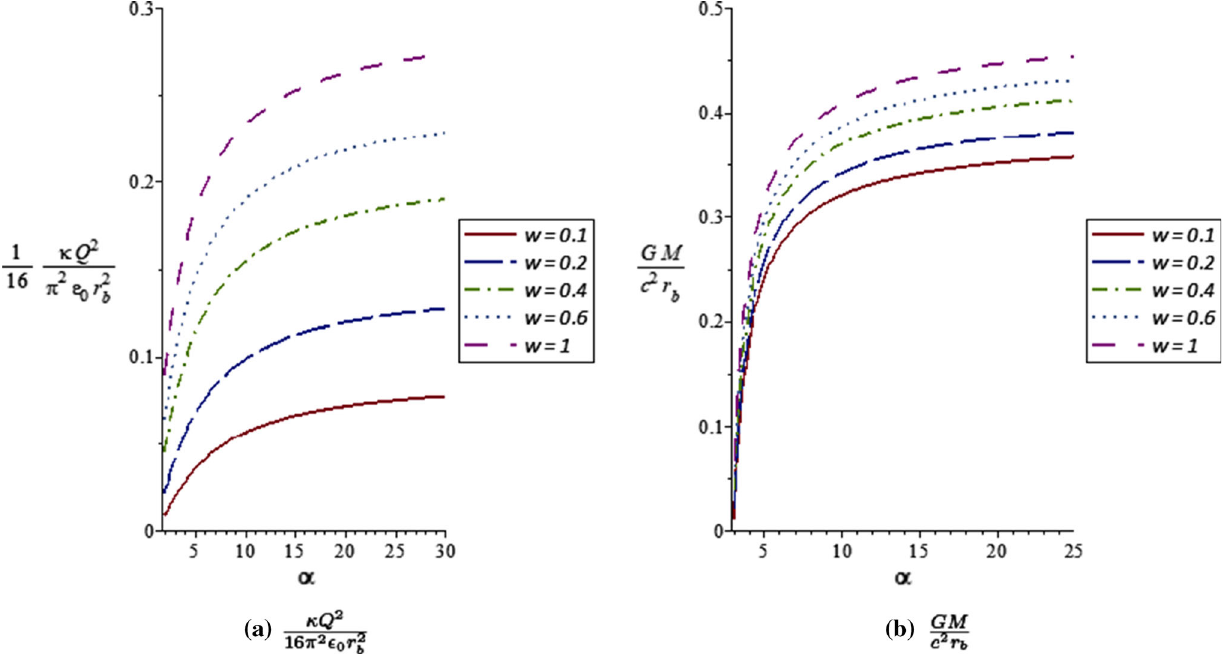
Fig. 5 The dimensionless quantities related with the total electric charge Q ( a ) and the total mass M ( b ) as a function of α for some different ω values and k =